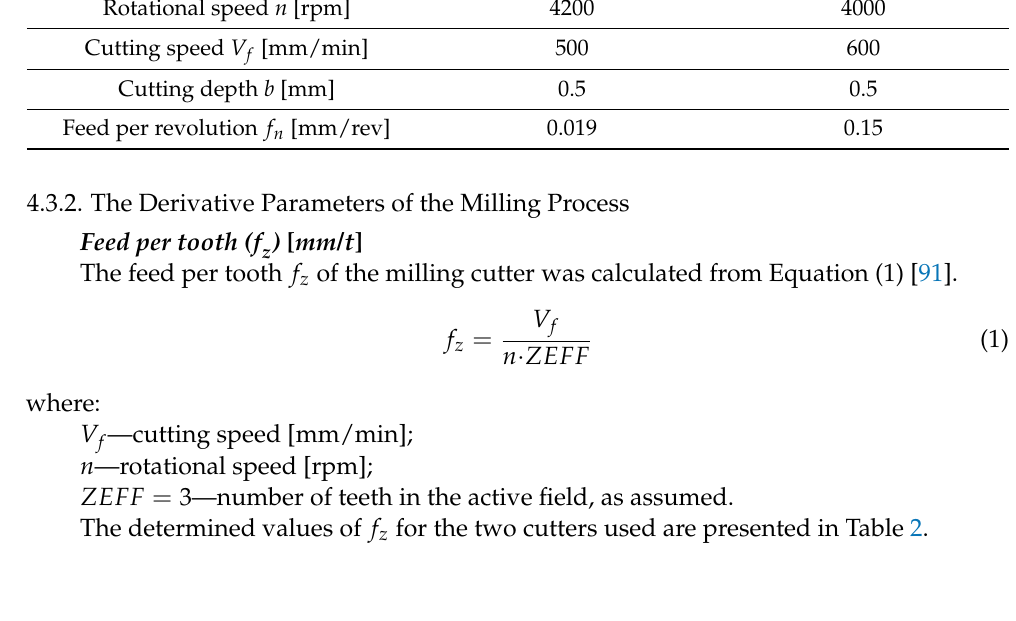
Table 1. Parameters of the end milling process for the two cutters used. Parameter Course Cutter ø4 Finishing Cutter